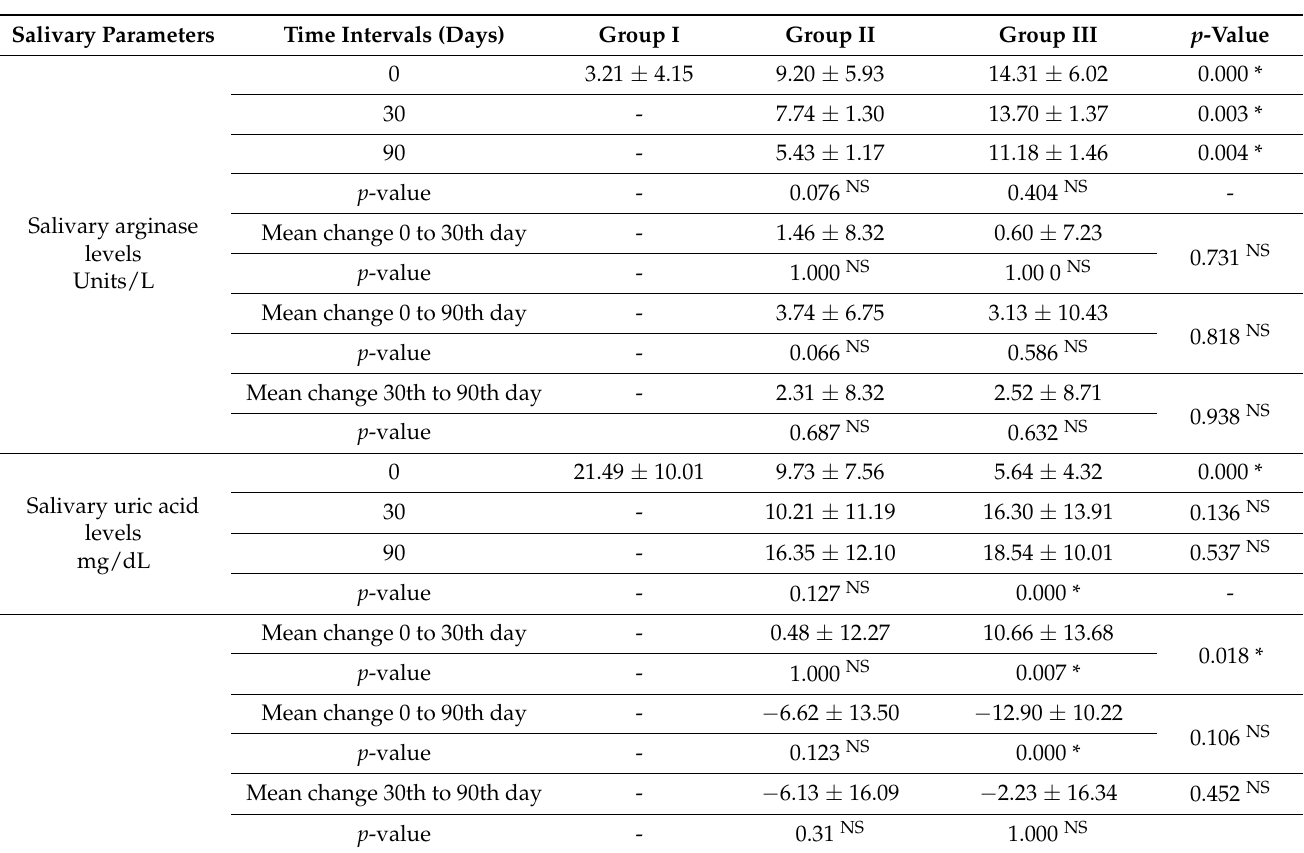
Table 2. Comparison of mean, standard deviation, and significant differences for salivary arginase and uric acid levels within and between groups at different time